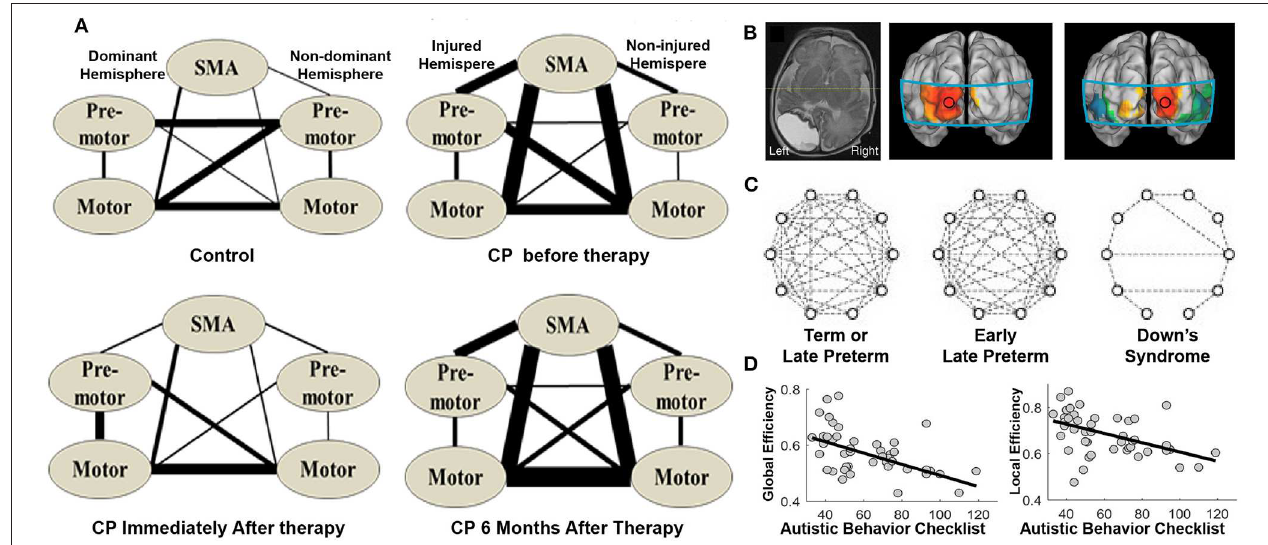
FIGURE 8 | Brain connectome in children with neurological disorders. (A) Brain connectome changes in cerebral palsy patients (CP) before, immediately after, and 6 months after the therapy. The thickness of the lines indicates the percentage of subjects with significant connectivity. (B) Structural MRI of a preterm infant with stroke and its functional connectivity maps with seeds in the left and right occipital cortex, respectively. (C) Brain connectome in each group. The dashed lines indicate correlation coefficients higher than 0.5. (D) Scatter plot illustrating the relationship between autistic behaviors and network efficiency (i.e., global and local efficiency). (A) is adapted from Cao et al. (2015) under a CC BY 4.0 license; (B,C) is adapted from White et al. (2012) and Imai et al. (2014), respectively, with permission from Elsevier; (D) is adapted from Li and Yu (2018) under a CC BY 4.0